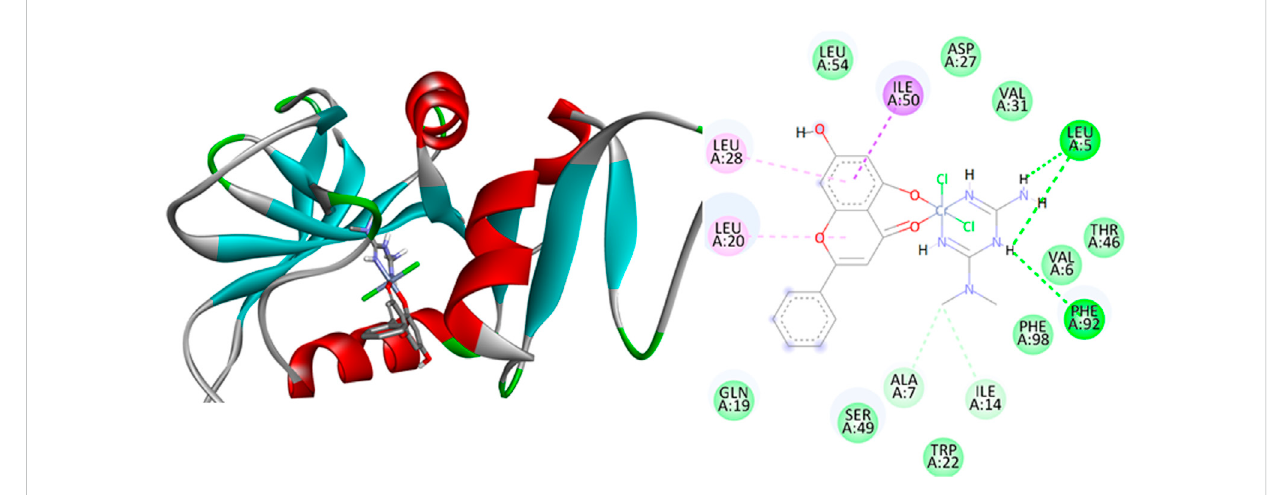
FIGURE 10 Binding interactions of Cr2 against Staphylococcus aureus (PDB: 2w9h).